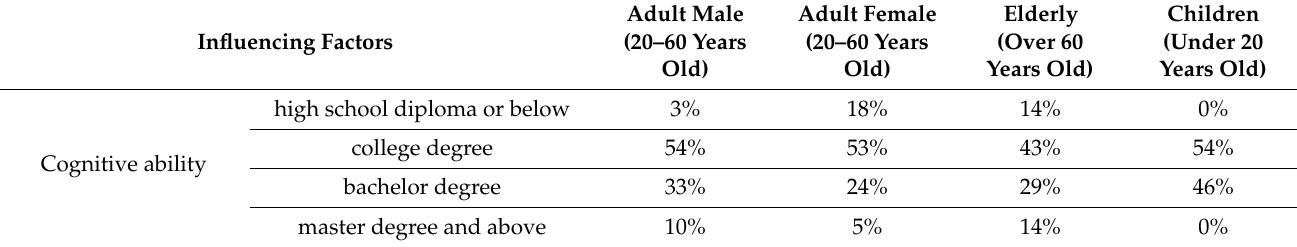
Table 2. Summary of questionnaire